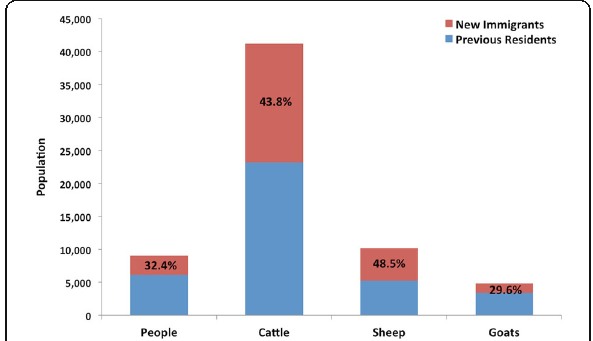
Figure 2 KGR populations in 2011 showing proportion of